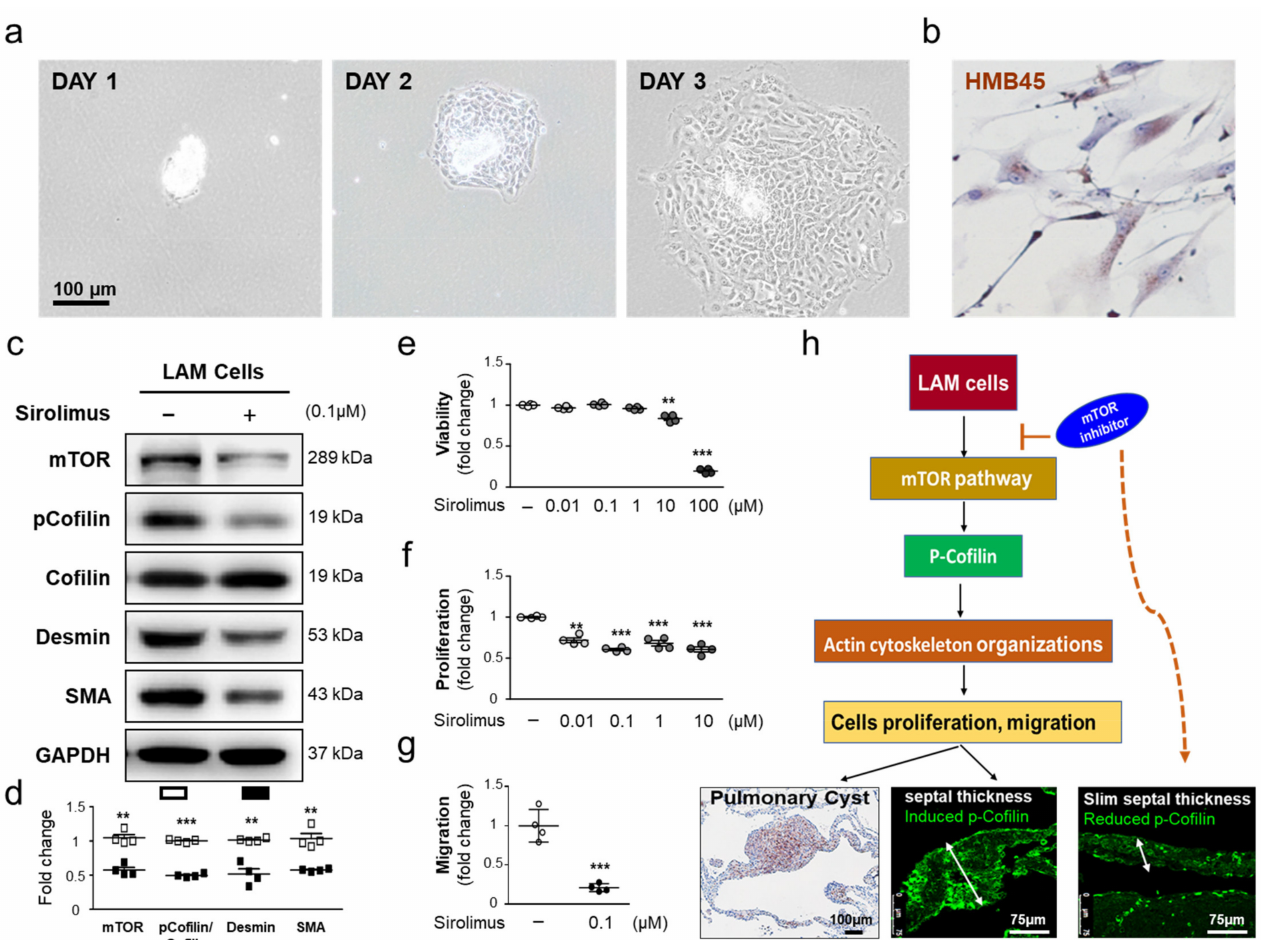
Figure 5. Effect of sirolimus on LAM cell proliferation and migration associated with mTOR and p-cofilin expression. ( a ) The LAM cell clusters (size between 70 µ m to 100 µ m) was isolated from LAM patients, the phase contrast images show the morphology of LAM cells in adherent culture at day 1, day 2, and day 3. The images were obtained using 40 × objectives. ( b ) The primary culture LAM cells were identified by the specific markers HMB45 to characterize the LAM cells. Immunocytochemistry showing HMB45 localization (brown staining; nuclear staining with hematoxylin in blue). ( c ) LAM cells were treated with or without sirolimus (0.1 µ M). Western blot was used to assess the protein expression levels in whole-cell extracts. ( d ) Relative expression values of mTOR, pCofilin, tCofilin, desmin, and SMA obtained by densitometry. The data are presented as the mean ± SEM of three samples in each group. ** p < 0.01 and *** p < 0.001 compared with LAM cells without sirolimus. ( e ) cell viability, ( f ) Sirolimus treatment inhibited the proliferation of LAM cells. ( g ) Sirolimus treatment inhibited the migration of LAM cells. The data (mean ± SEM [ n = 4]) are presented as the fold change in cell numbers compared with those in the untreated group. *** p < 0.001 compared with the untreated group. ( h ) the schema: possible mechanisms of mTOR inhibitor in LAM via decreased